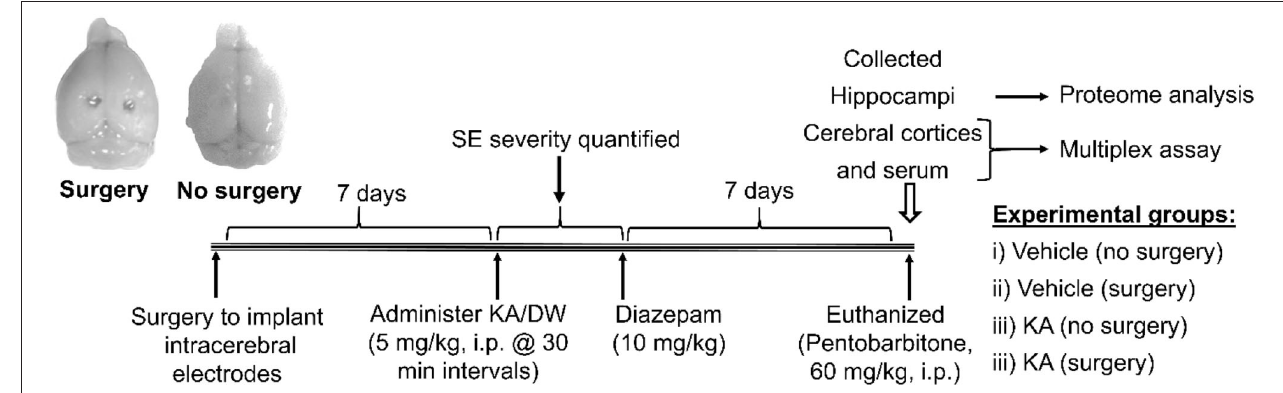
FIGURE 1 | The experimental design. The brain image on the left illustrates the gross impact of the intracerebral electrodes (surgery), and the image on the right is from a mouse with no